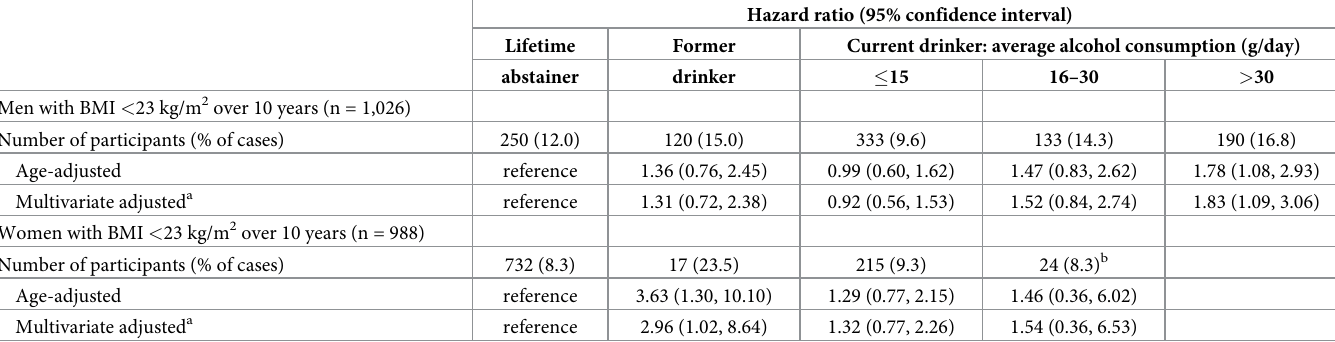
Table 3. Sex-specific association between alcohol consumption and 10-year incidence of type 2 diabetes mellitus among participants who maintained leanness over the follow-up